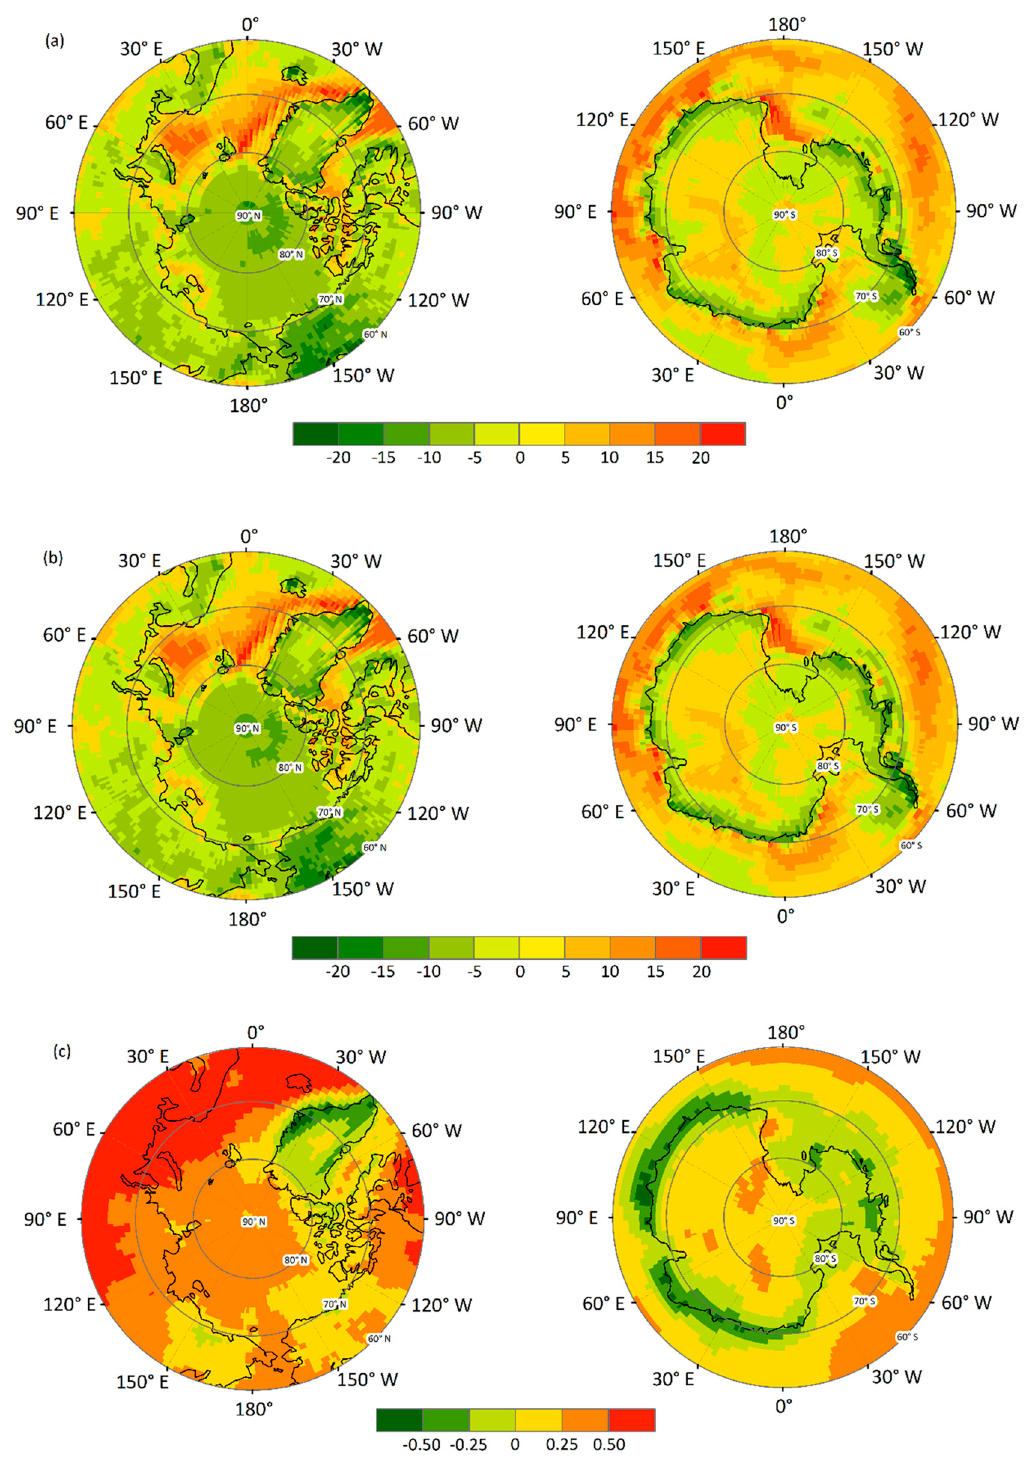
Figure 7. Geographical distribution of the different values ( a ) between the BMA results and the CERES EBAF retrievals, ( b ) between the SMA results and the CERES EBAF retrievals, and ( c ) between the SMA results and the BMA results from 2000 to 2005 (in units of W m -2 ). The results shown in ( c ) is 1-2 orders of magnitude smaller than those in ( a ) and ( b ).